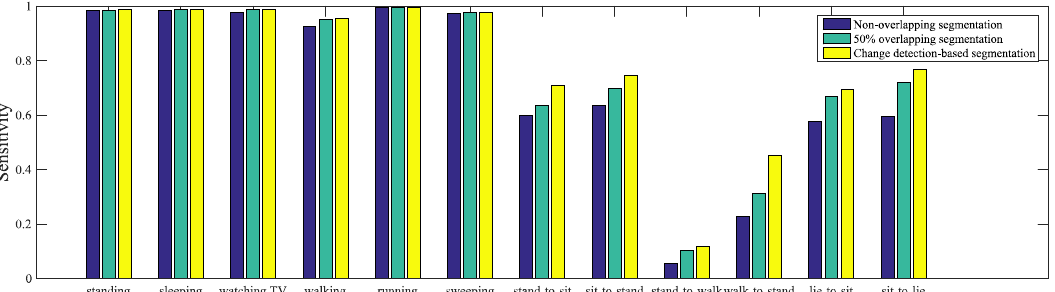
Figure 2. The sensitivity of each activity class obtained from three segmentation methods by applying SVM classifier.